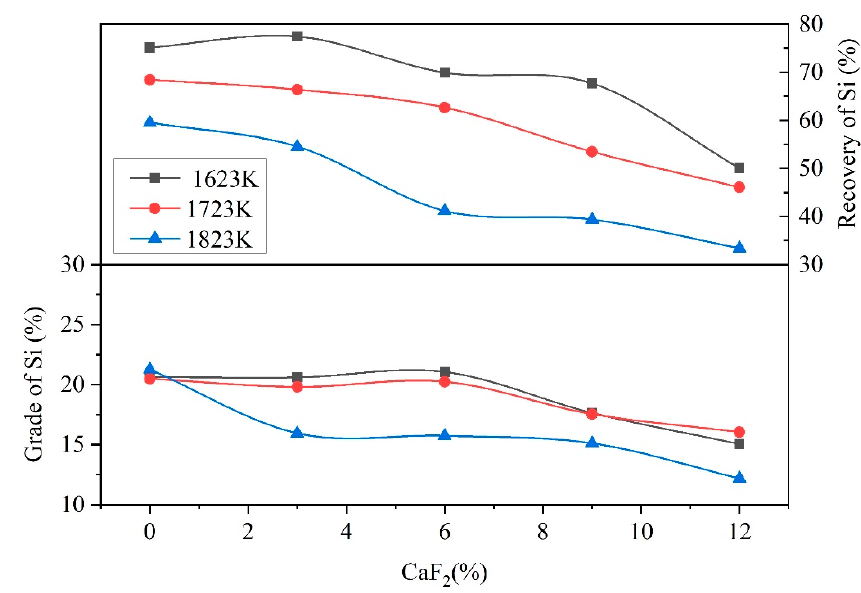
Figure 15. The effect of additives and temperature on Si enrichment (%). The upper three lines in the figure represents the recovery of Si, and the lower three lines in the figure represents the grade of Si.